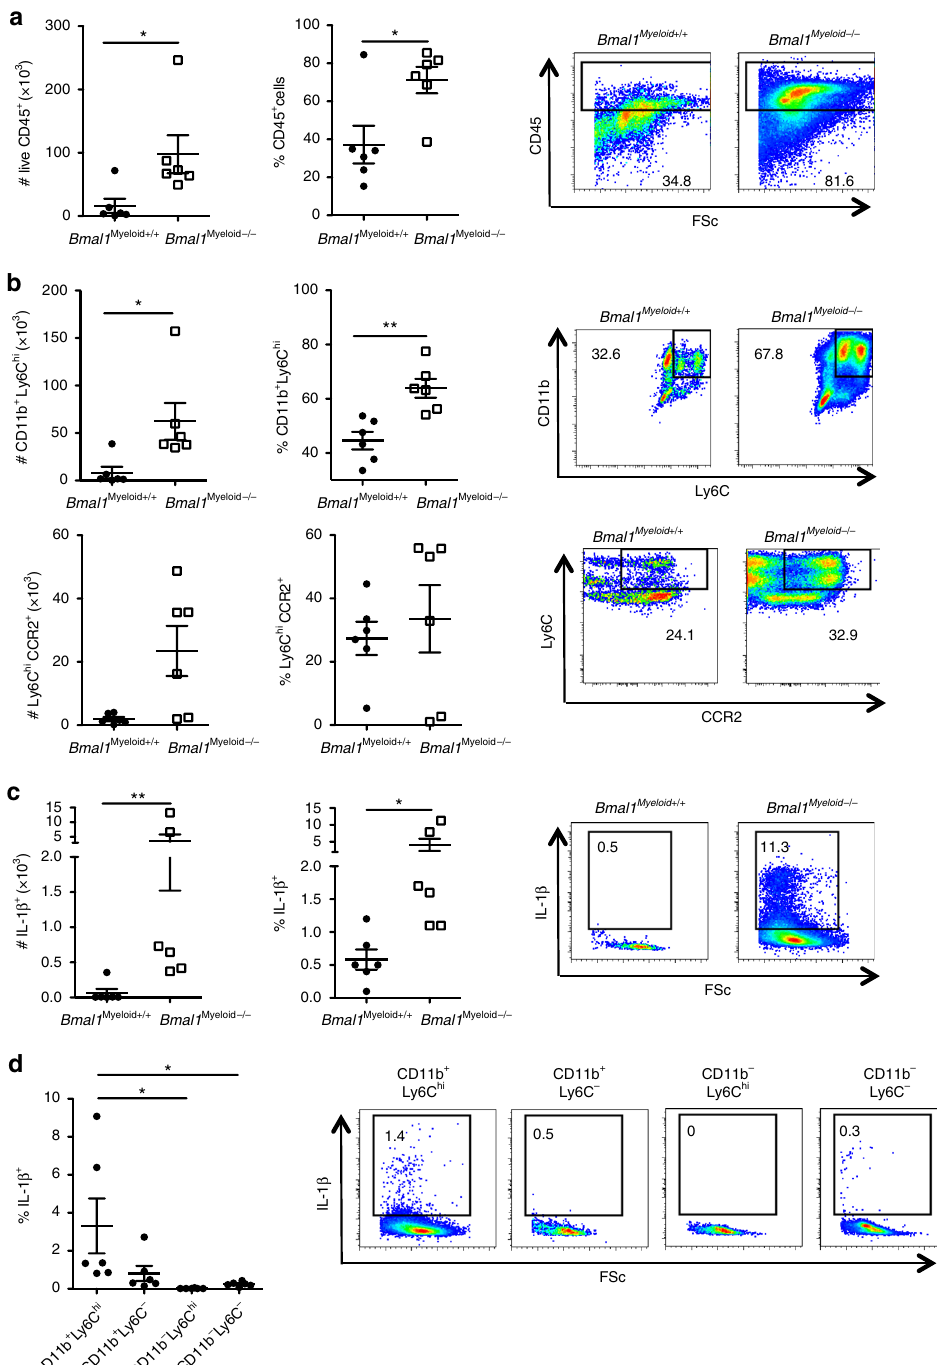
Fig. 3 Enhanced accumulation of in fl ammatory CD11c + Ly6C + cells producing IL-1 β in the CNS of Bmal1 Myeloid − / − mice during EAE. a – c Bmal1 Myeloid + / + and Bmal1 Myeloid − / − mice were immunized to develop experimental autoimmune encephalomyelitis (EAE) with myelin oligodendrocyte glycoprotein (MOG 35 – 55 ) + complete Freund ’ s adjuvant (CFA) on d 0 and with pertussis toxin (PT) (125 ng/mouse) on d 0 and d 2 ( n = 6). a D 10 post EAE induction live cells in fi ltrating into the spinal cord were FACS stained for CD45 ( n = 6). b Live CD45 + cells were examined for Ly6C v CD11b or CCR2 v Ly6C ( n = 6). c IL-1 β expression was determined in live CD45 + CD11b + Ly6C + cells ( n = 6). d 10 d post immunization CD11b and Ly6C populations in fi ltrating the spinal cord of Bmal1 Myeloid − / − mice were examined for IL-1 β expression by FACS, gating on live CD45 + cells ( n = 6). Data as means ± standard error of the mean (SEM). Statistics were performed by Mann – Whitney U test a – d . * p < 0.05; ** p < indicate that the increase in disease severity after immunization at immunized at ZT6 compared with ZT18 (Fig. 6e) ( p < 0.05, ZT6 compared with ZT18 can be attributed to enhanced Mann – Whitney U test). The number of IL-1 β -producing Ly6C + accumulation of in fl ammatory monocytes and increased IL-1 β cells were also increased, though not signi fi cantly, in mice − / − production, similar to that observed in Bmal1 Myeloid immunized at ZT6 compared with ZT18 (Fig. 6e). These fi ndings mice.